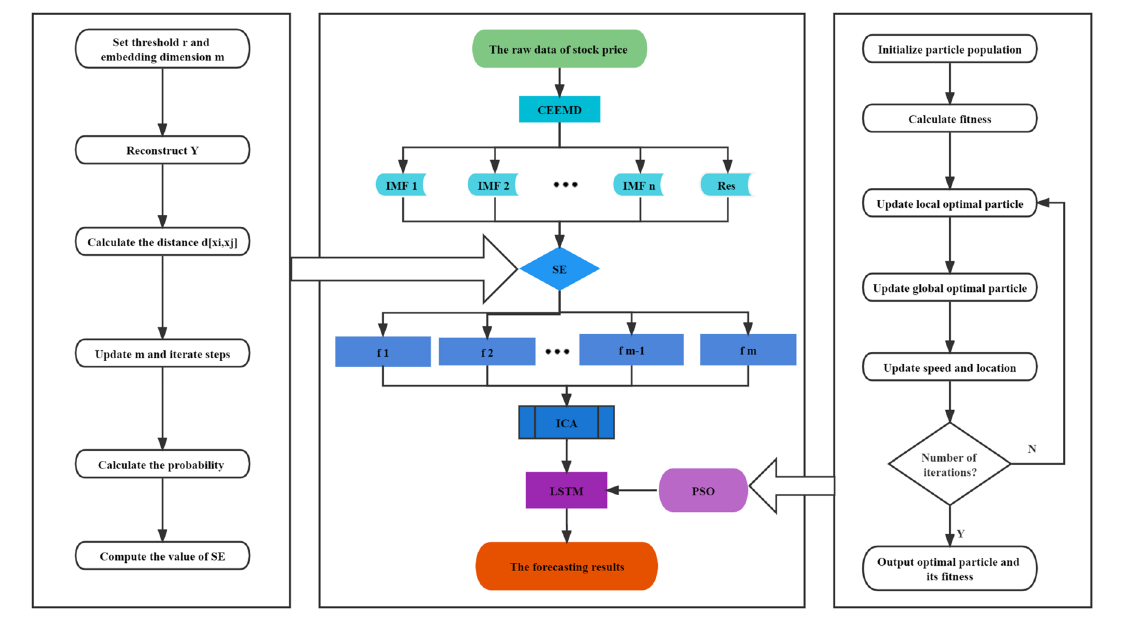
Fig. 2 Framework of the Proposed Forecasting Model Table 1 The parameter setting of these